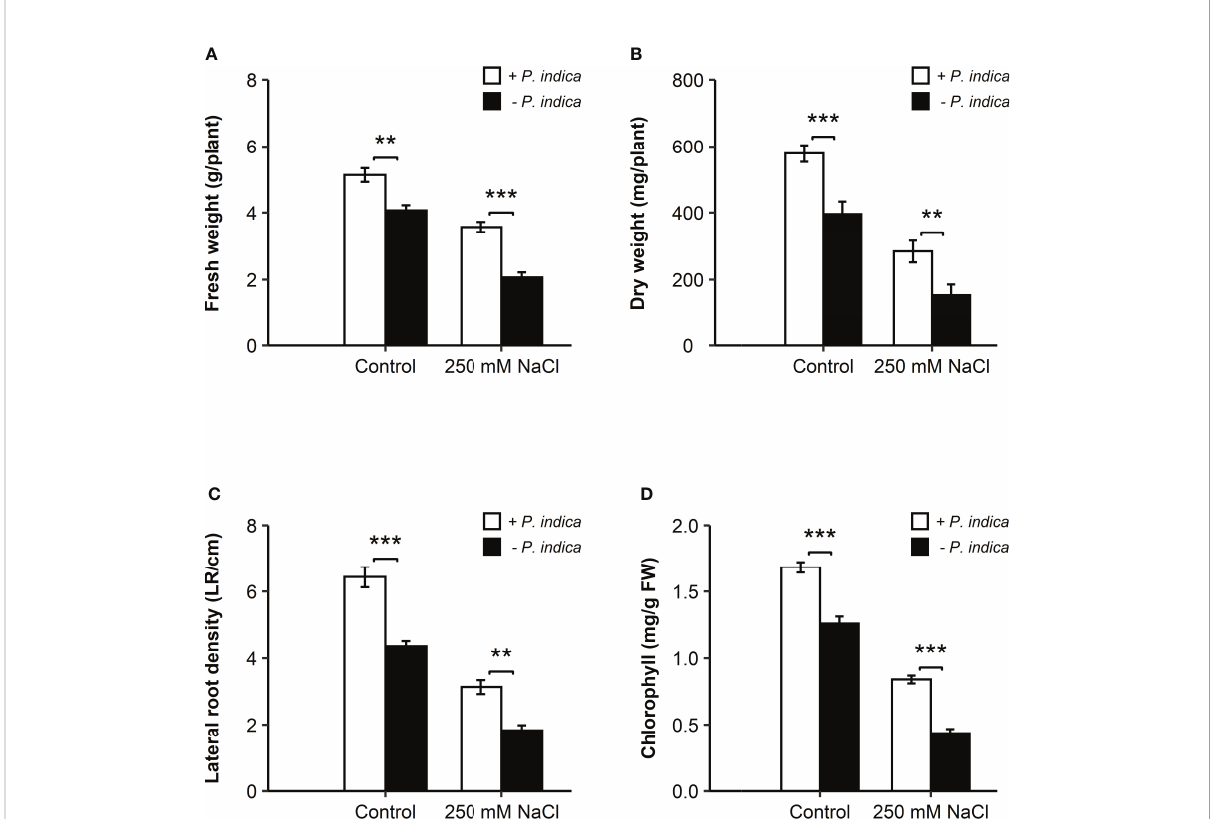
FIGURE 2 Effects of P. indica inoculation on the growth of date palm seedlings under normal (0 mM NaCl) and salt stress (250 mM NaCl) conditions. (A) Fresh weight (g/plant) of the inoculated and control plants. (B) Dry weight (mg/plant) of inoculated and control plants. (C) Lateral root density (LR/cm) of the inoculated and control plants. (D) Chlorophyll content (mg/g FW) of the inoculated and control plants. The values are the means ± SD (n = 3), analyzed by Student ’ s t- test, **p < 0.01 and ***p <